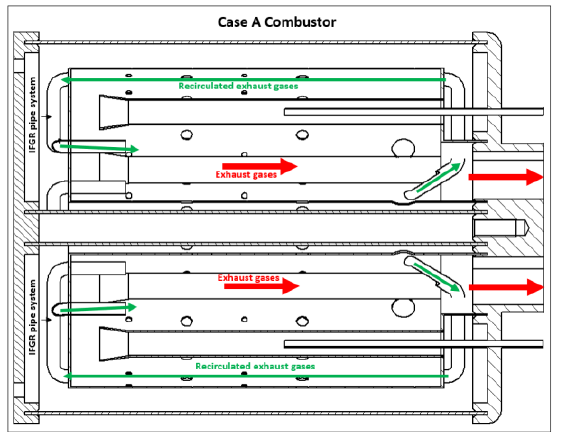
Fig. 3. Cross sectional view of 3D model of modified combustor (case A)